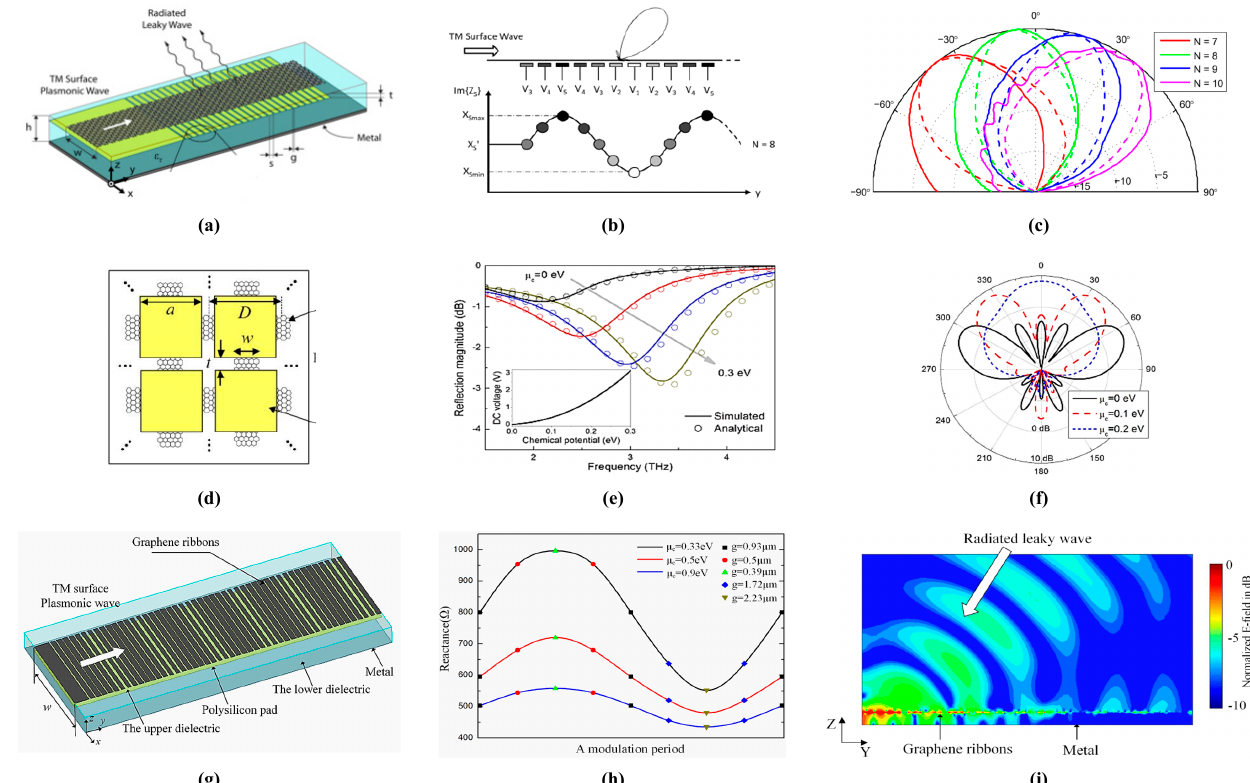
Figure 16. ( a ) Schematic of a graphene leaky-wave antenna (LWA), with a graphene sheet placed on top of gating pads. ( b ) Representation of the graphene reactance with respect to DC voltage at the gate pads. ( c ) Radiation beams of the LWA; as the parameters are changed by applying gate voltage, the beam steers in either direction, keeping the distance between gate pads constant (i.e., g = 0.2 µ m). ( d ) Geometry of a graphene-integrated leaky-wave antenna with metasurfaces. ( e ) Tuning of reflection magnitude through simulation and analytical means; when the chemical potential is increased from 0 to 0.3 eV, the resonance peak shifts to higher frequencies with increasing reflection magnitude. ( f ) 2D radiation pattern of the integrated high-impedance surface (HIS) antenna with beam scanning ability as the chemical potential is raised. ( g ) Geometric representation of sinusoidally modulated LWA; graphene nanoribbons with unequal strip width are placed on the polysilicon gate. ( h ) Modulated reactance of LWA by altering the parameters of the graphene and the space between graphene sheets. ( i ) Electric field pattern of the radiated beam from the LWA. © 2013 OSA, © 2015 IEEE © 2018 APS. Reprinted with permission from